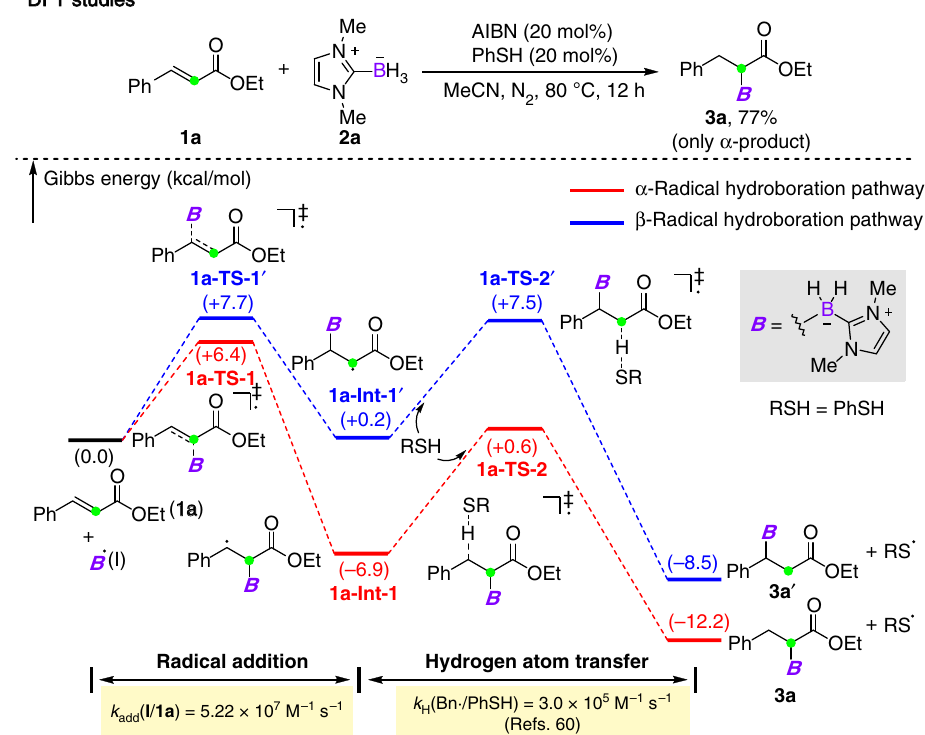
Fig. 4 Theoretical calculations. DFT calculations of the radical hydroborylation of